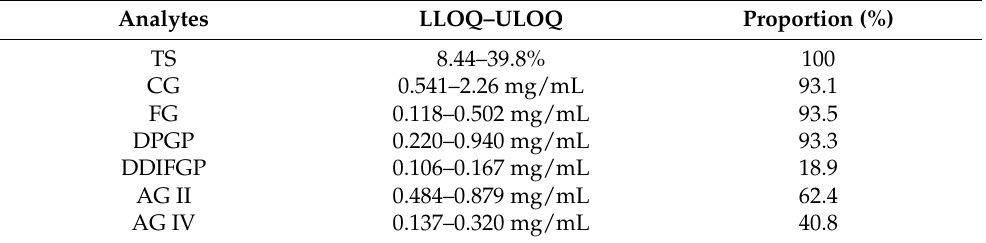
Table 8. The valid range for each analyte and its proportion over the studied content